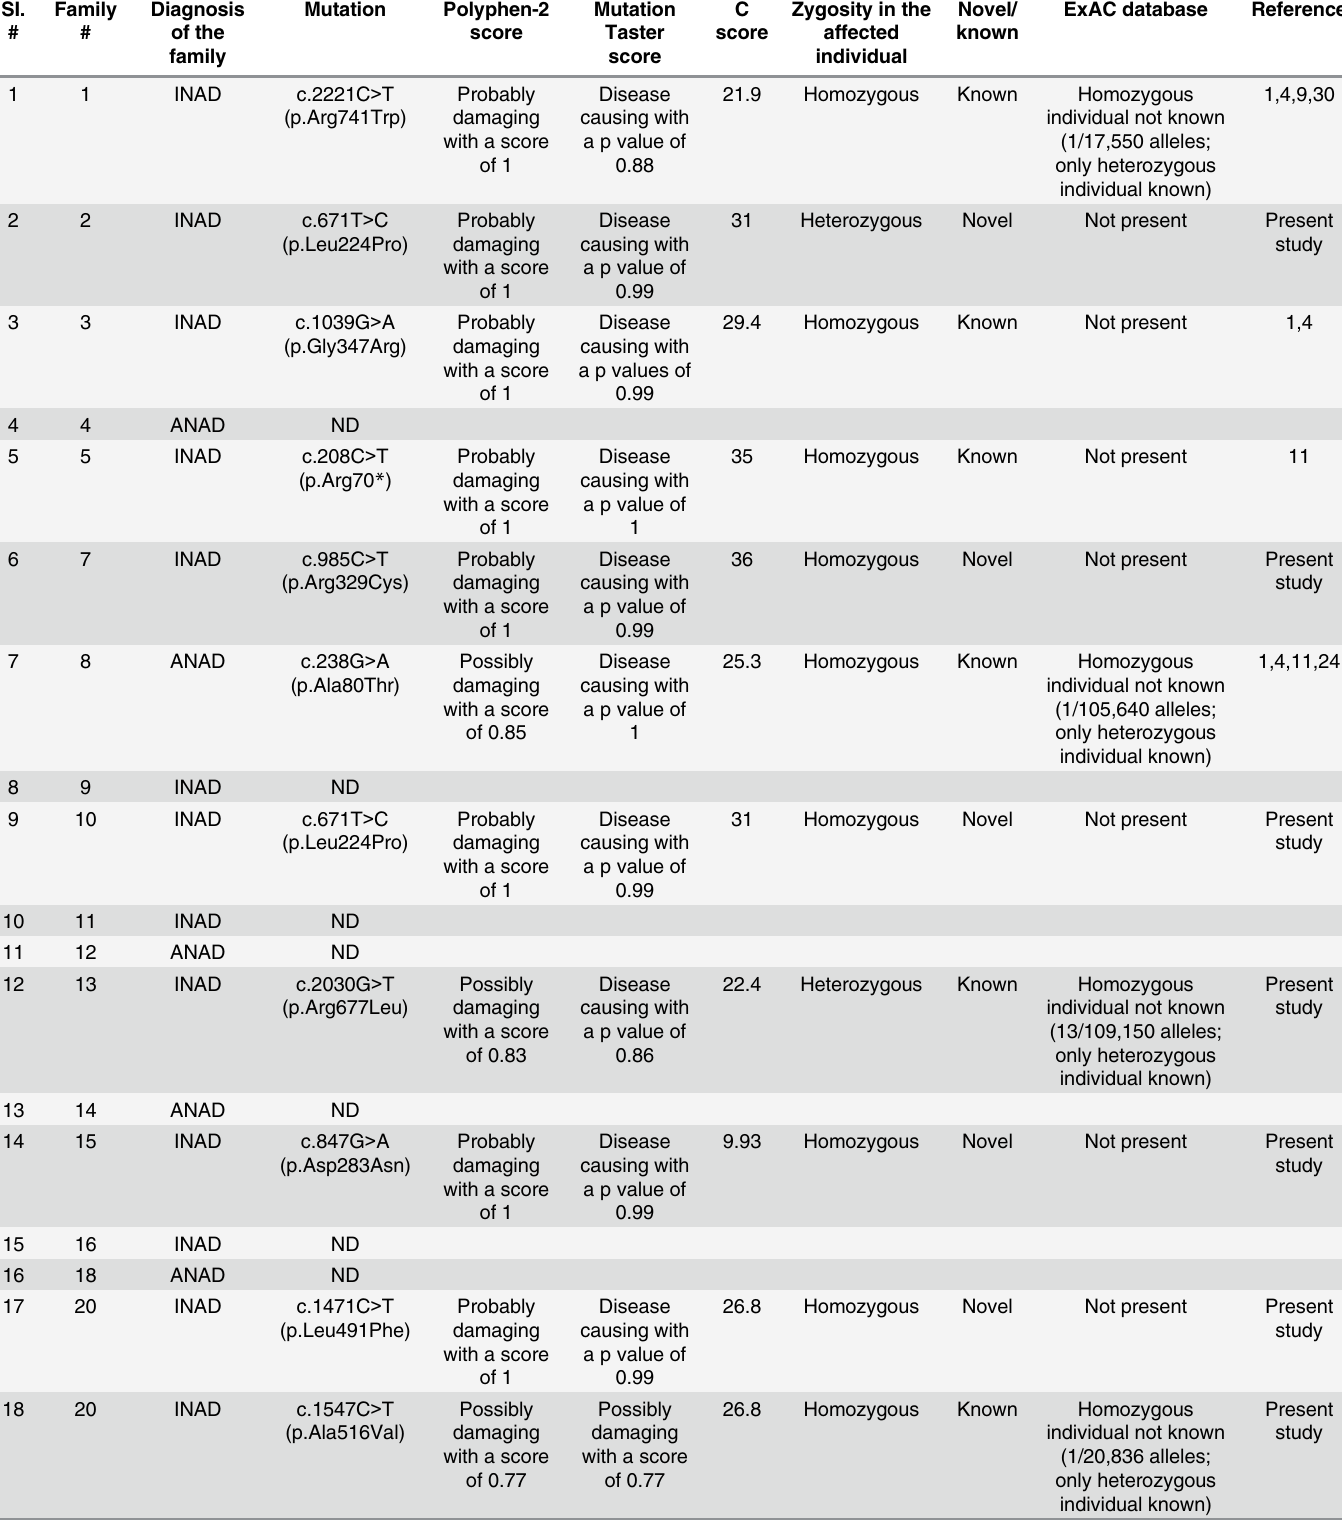
Table 2. Details of the PLA2G6 mutations identified during the present study. SI.